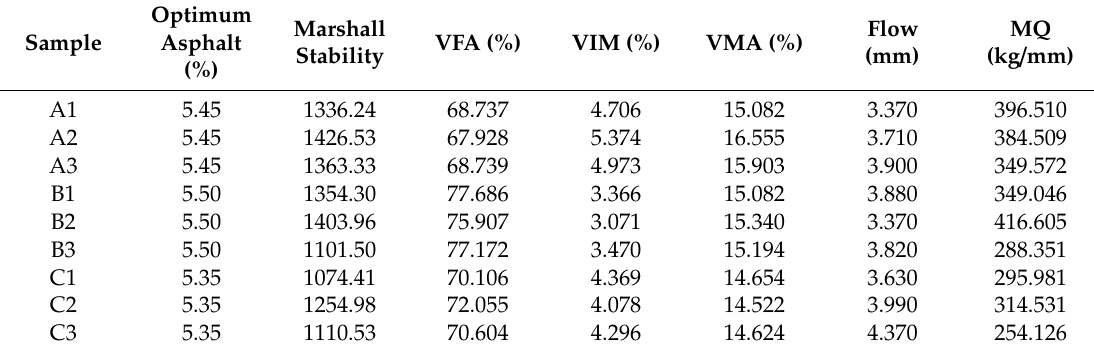
Table 5. Characterization of Marshall stability.